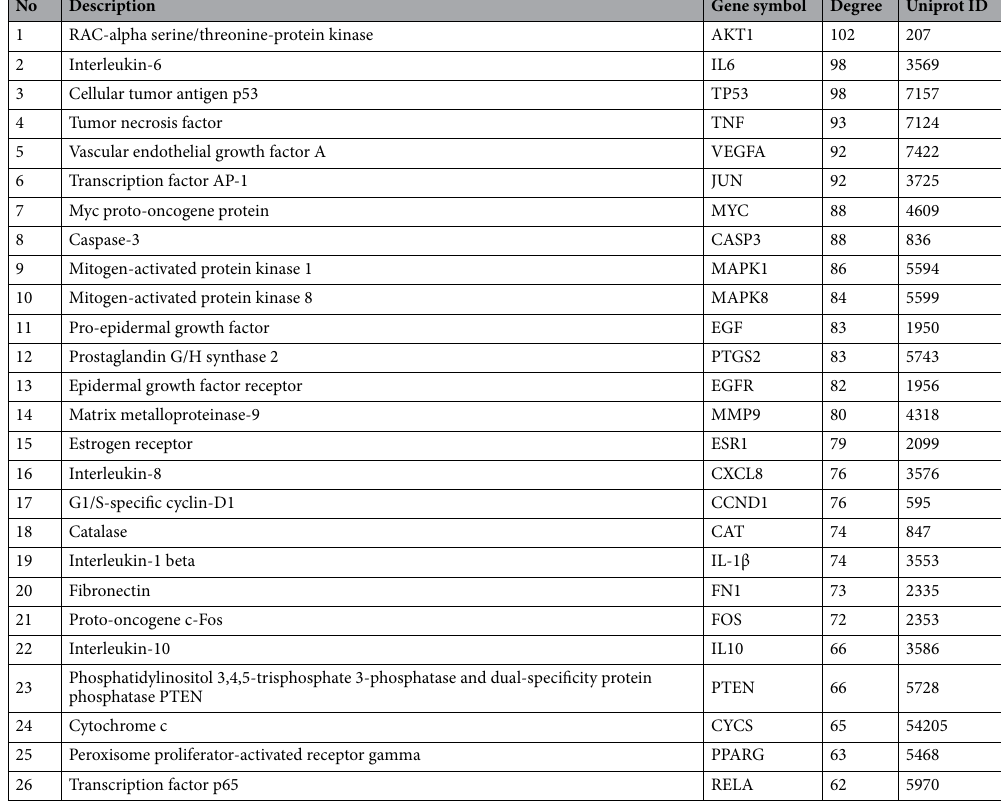
Table 2. The information of 26 core